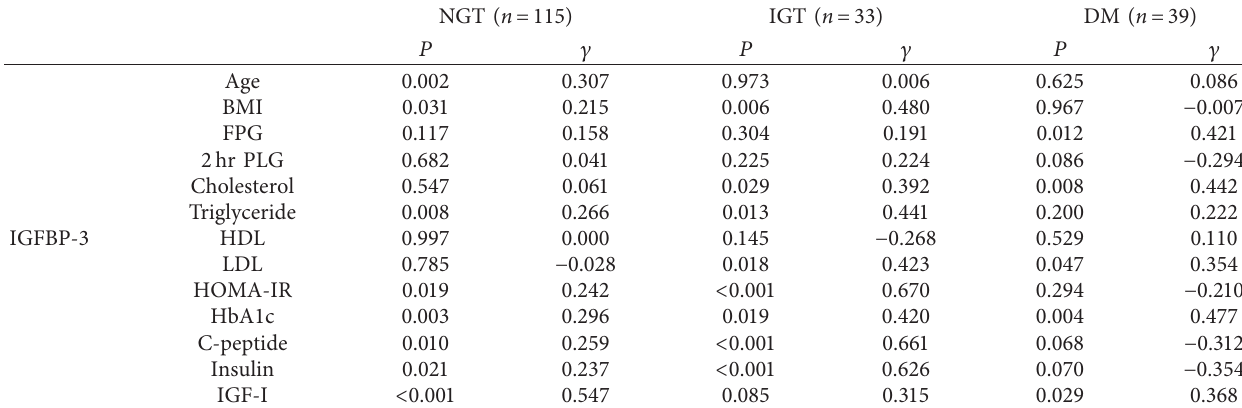
Table 5: Simple correlation ( c ) between serum IGFBP-3 and clinical